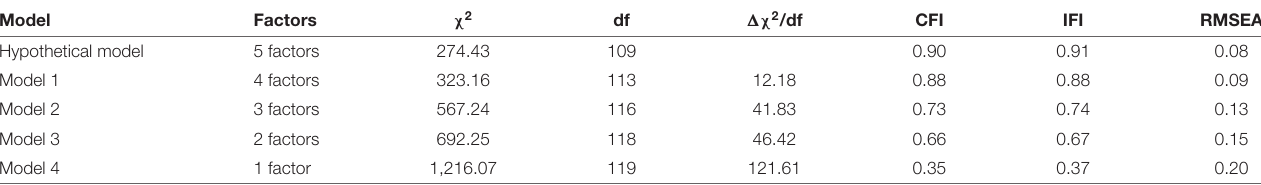
TABLE 2 | Results of confirmatory factor analyses of the measures ( N =